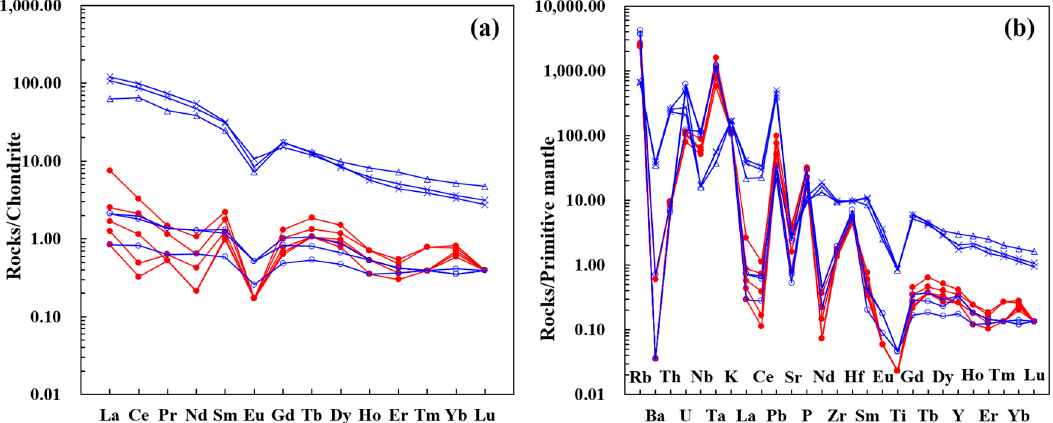
Figure 5. Distribution patterns of REEs and trace elements in the Dongcao muscovite granite: ( a ). chondrite–normalized REE patterns; ( b ). primitive mantle–normalized trace element patterns. (Legend description: the red dots are data of the Dongcao muscovite granite samples in this paper; the blue crosses are data of the Dagang protolothionite muscovite granite; the blue triangles are data of the Dagang pegmatitic dike; and the blue circles are data of the Dagang lepidolite alkali–feldspar granite [8]. The standardized data of chondrites and primitive mantle are from [26].).